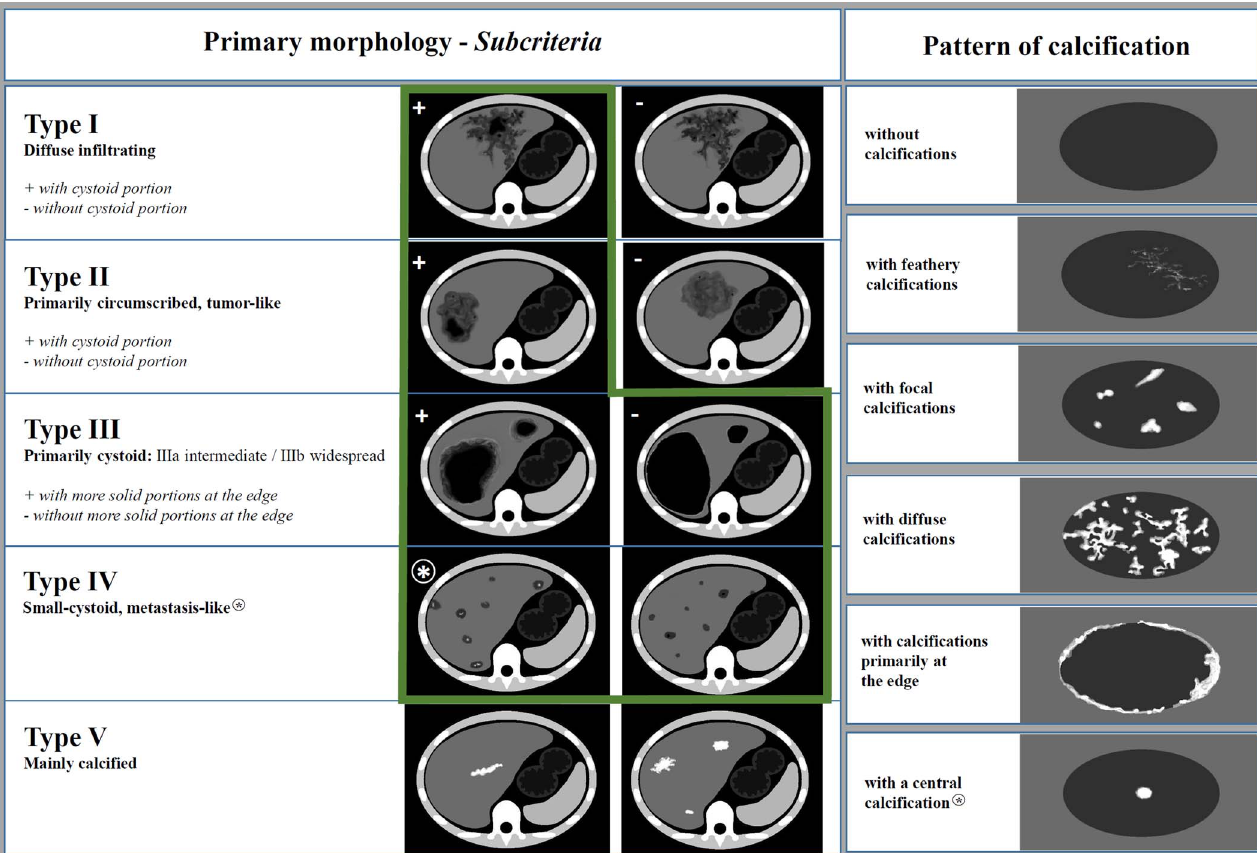
Figure 1. Overview of the EMUC-CT after Graeter et al. Left: Primary morphological types I – V and their subcriteria (applicable to types I, II and III). Right: Patterns of calci fi cation. (EMUC-CT = Echinococcus multilocularis Ulm Classi fi cation for Computed Tomography). The two columns of the classi fi cation are primarily considered separately and can then in principal be freely combined. There are two exceptions: The pattern of calci fi cation “ with a central calci fi cation* ” can only occur with primary morphology type IV* and primary morphology type V is not further characterised by a pattern of calci fi cation. Lesions of types I and II with cystoid portions as well as types III and IV were evaluated (marked with a green